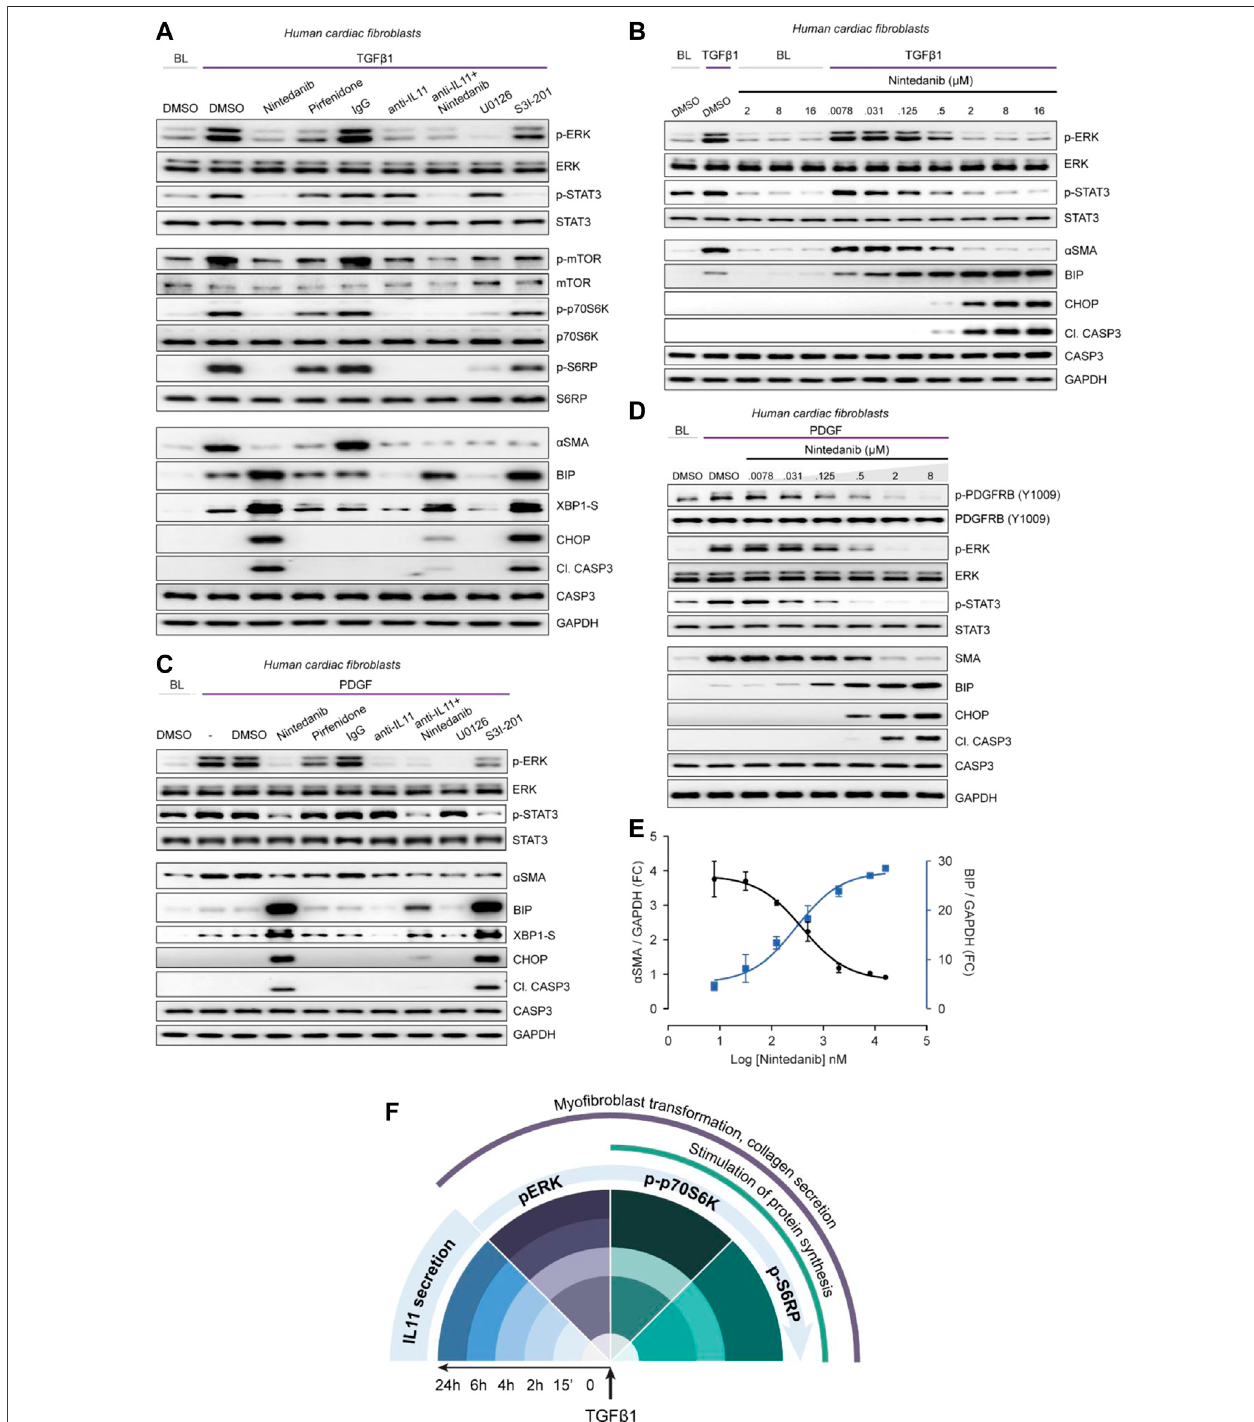
FIGURE 5 | Nintedanib, Pirfenidone and anti-IL11 have different anti- fi brotic mechanisms of action in cardiac fi broblasts. (A) Western blots showing activation status of ERK, STAT3, mTOR, p70S6K (T389), S6RP, and Caspase3, and protein expression of ⍺ SMA, BIP, XBP1-S, and CHOP following treatment with nintedanib, pirfenidone, IgG, anti-IL11, a combination of nintedanib, anti-IL11, U0126 or S3I-201 from TGF β 1-stimulated HCFs ( n (cid:2) 1). (B) Western blots of p-ERK, ERK, p-STAT3, STAT3, ⍺ SMA,BIP,CHOP,CleavedCaspase3,Caspase3,andGAPDHfromHCFstreatedwithdifferentconcentrationsofnintedanibintheabsenceorpresence ofTGF β 1( n (cid:2) 1). (C) Westernblotsofp-ERK,ERK,p-STAT3,STAT3, ⍺ SMA,BIP,CHOP, CleavedCaspase3,Caspase3,XBP1-S,andGAPDHfromPDGF-stimulated HCFs ( n (cid:2) 1). (D) Western blots of p-PDGFRB, PDGFRB, p-ERK, ERK, p-STAT3, STAT3, BIP, CHOP, Cleaved Caspase 3, Caspase 3, and GAPDH